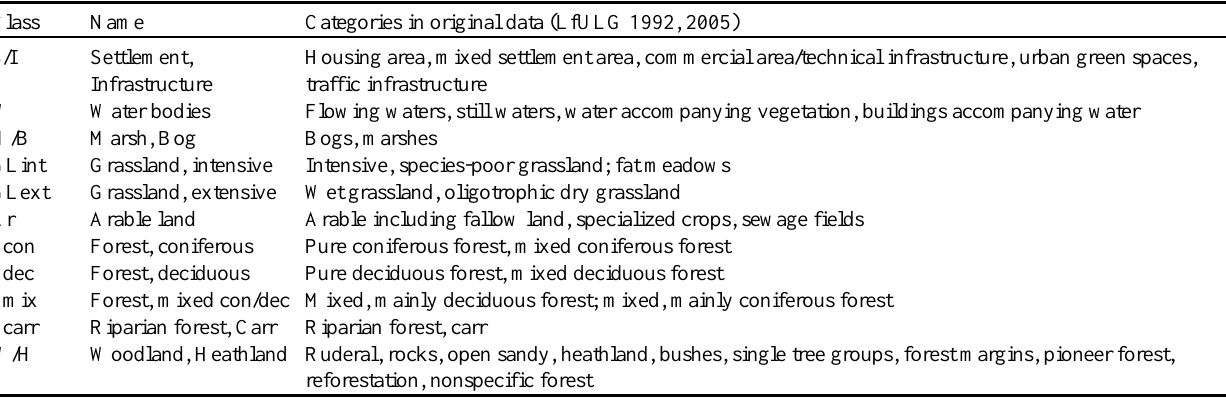
Table 2 . Composition of classes